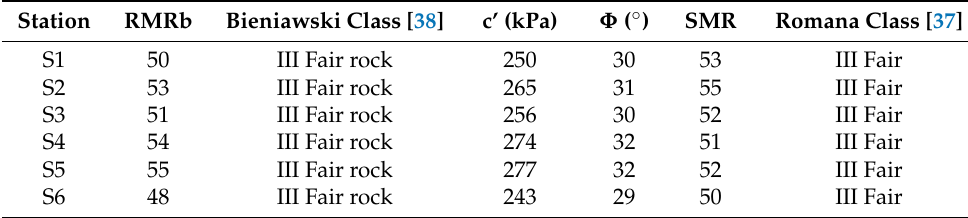
Table 2. Summary of the outcomes of geomechanical classifications.